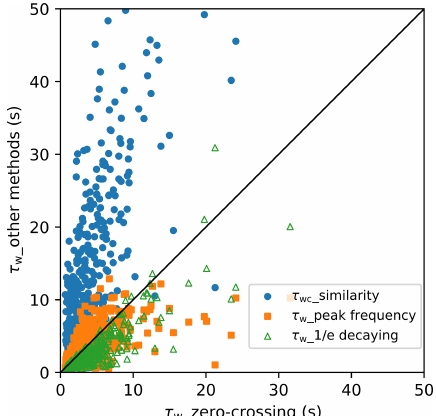
Figure B1. Comparison of integral timescales of w estimated by four different methods. Estimated integral timescales from the zero crossing method (integrating the auto-covariance function up to first zero crossing the function) agree well with the estima- tion of peak frequency method (Eq. B3). However, the similarity method (Eq. B2) overestimates the integral timescale, whereas the 1 /e decaying method (determining the time needed for the auto- covariance coefficient function value to decay to 1 /e ) tends to un- derestimate the integral timescale.